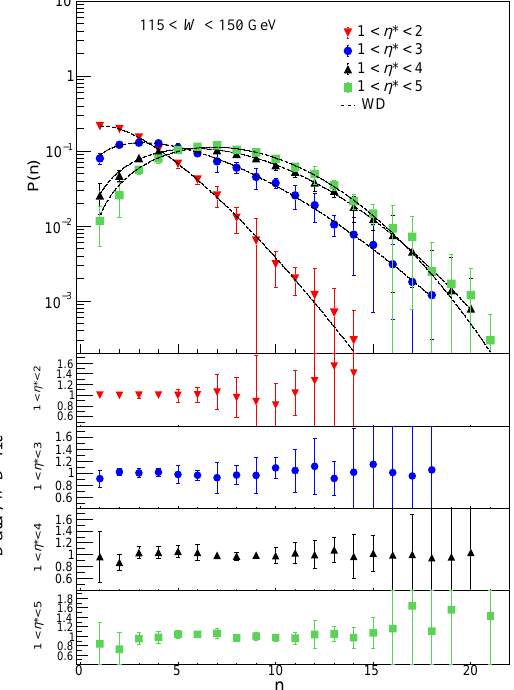
Figure 7. Multiplicity distributions fits with the WD probability function in 115 < W < 150 GeV in different η ∗ ranges of the H1 data [33]. The lower panel shows the data/WD-fit ratio plots for different η ∗ regions.